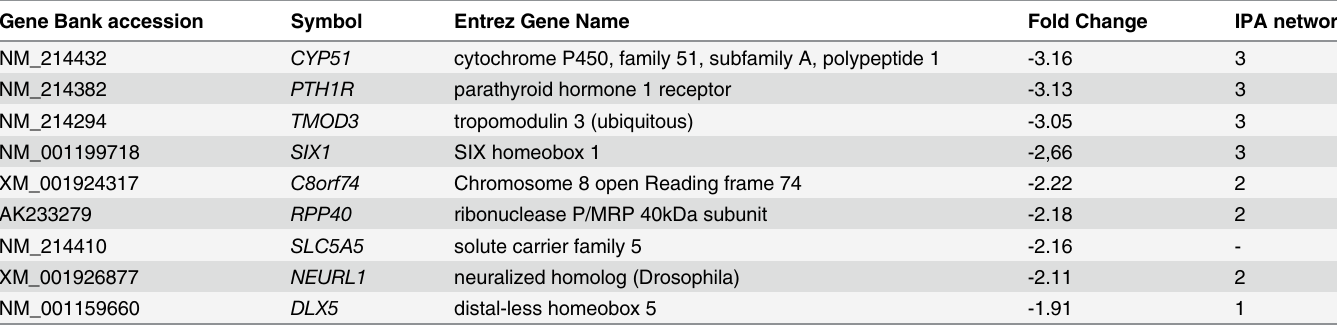
Table 3. Genes down-regulated in oviduct in artificially inseminated